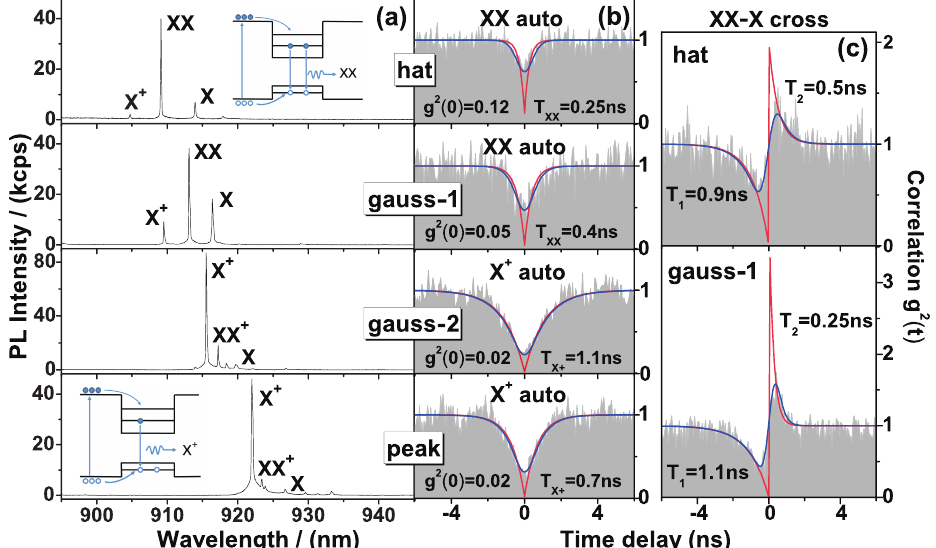
Figure 3. Typical µ PL spectra ( a ) and secondorder autocorrelation function g ( 2 ) ( τ ) ( b ) of QDs in the three types of MLs, red: deconvolution fitting, blue: convolution fitting. ( c ) XX – X cross-correlation function g ( 2 ) ( τ ) of QDs in the gauss -1 and hat MLs. Inset: theoretical schemes of QD biexciton ( XX ) and charged exciton ( X + )